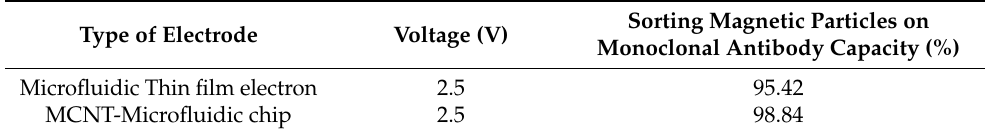
Figure 9. Magnetic particles flow on a monoclonal antibody in microstructure flow channel with microfluidic chip. Table 5. Separation of the sample magnetic particles on monoclonal antibody in microstructure flow channel with microfluidic and MWCNT-microfluidic chip.